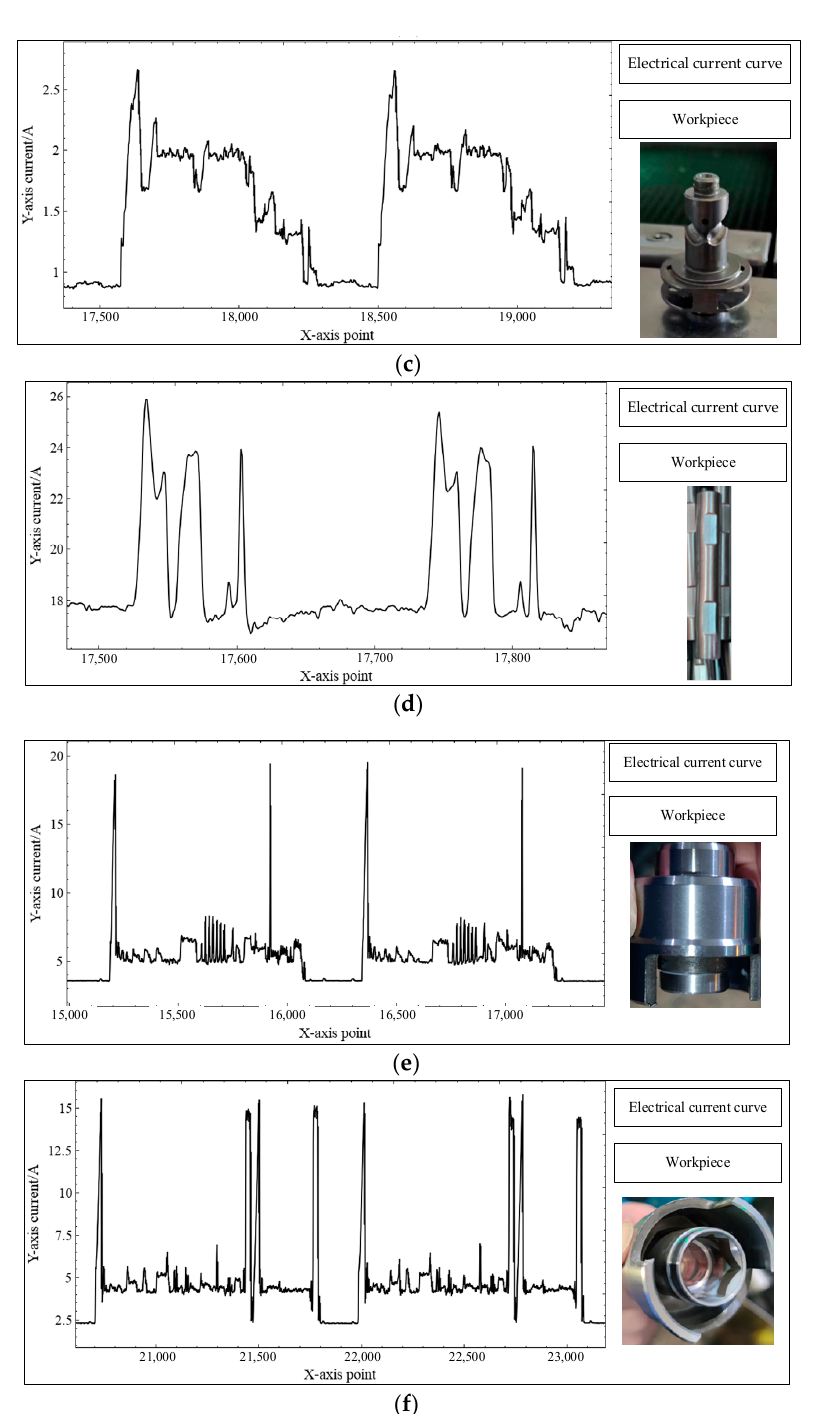
Figure 5. Photos and machining electric current curves of the experimental parts: ( a ) Toolholder— Turning small end bore; ( b ) Toolholder—Boring big end bore; ( c ) DriveShaft—Milling Ballways; ( d ) DiffCrossShaft—Forging; ( e ) HUB—Rough turning of end face outer and inner holes; ( f ) HUB— Fine turning of end face outer and inner holes.